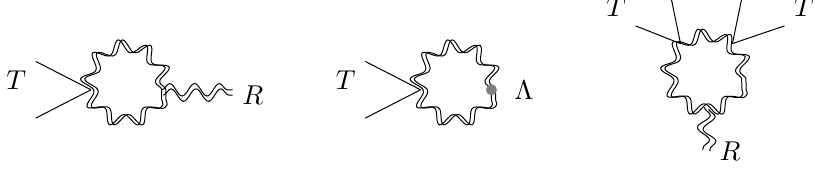
Figure 3 . Schematic of the UV divergent terms at one